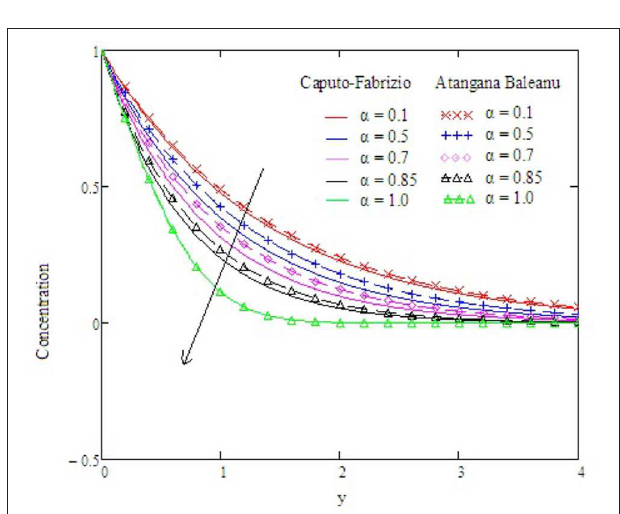
1.5, G r 2, P reff 0.1, G m 0.75, and M = = = =